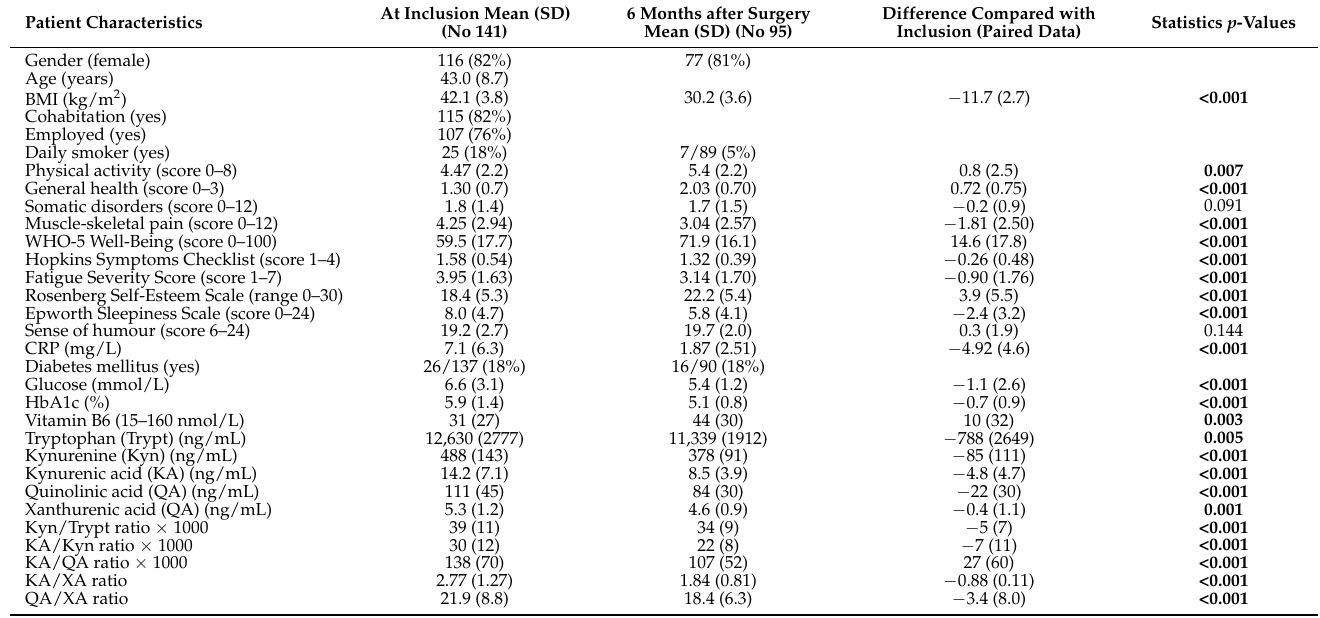
Table 1. Patients’ characteristics. The results are given as number (proportion, %) and mean (SD). Patient Characteristics At Inclusion Mean (SD) (No 141) Difference Compared with Inclusion (Paired Data) Statistics p